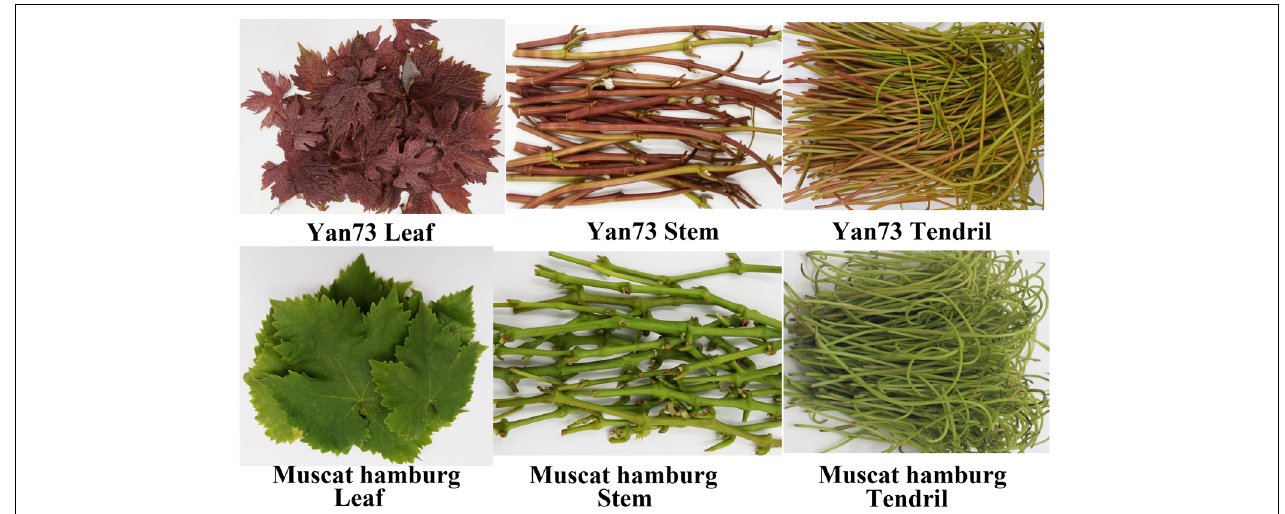
FIGURE 1 | Photos of leaf, stem, and tendril tissues from Yan73 grapevine and its male parent (Muscat Hamburg).